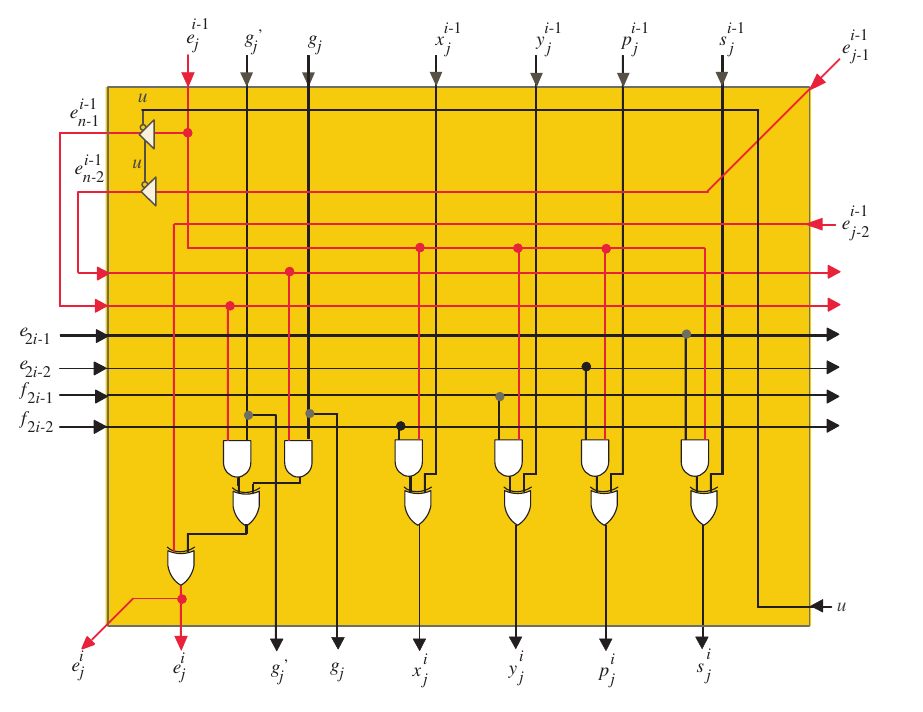
Figure 6. Logic details of the dark orange PEl.